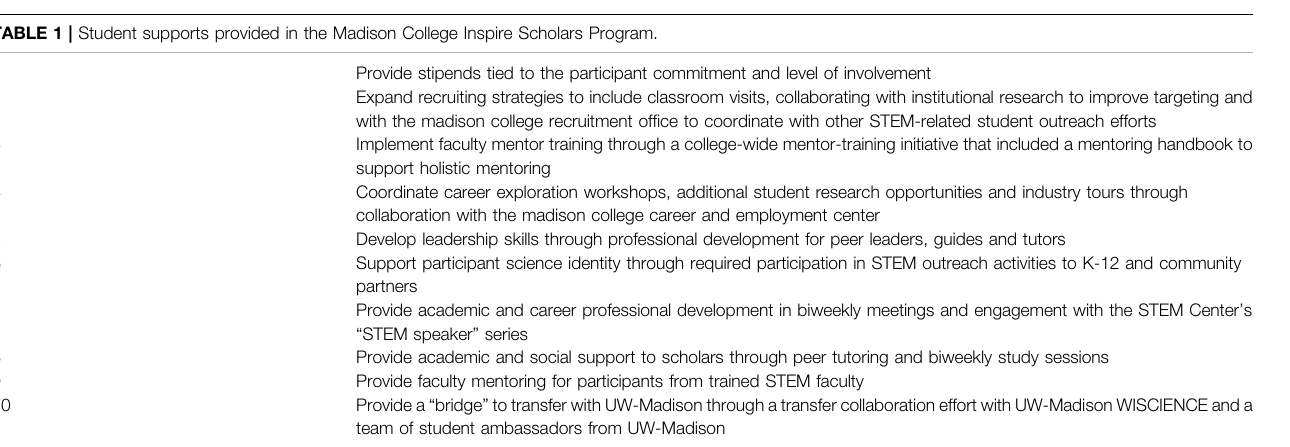
TABLE 1 | Student supports provided in the Madison College Inspire Scholars